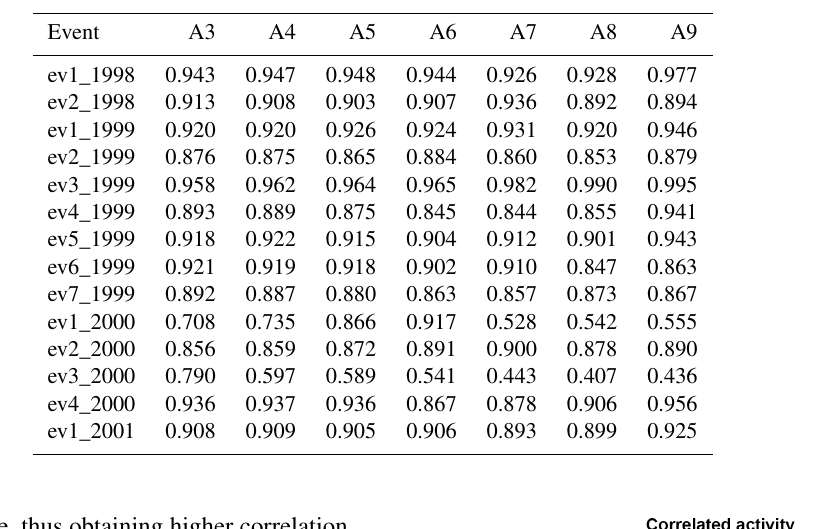
Table 3. Correlation coefficients between the calculated (AE ∗ ) and the observed (AE index) series for each event and in each wavelet decomposition approximation level.